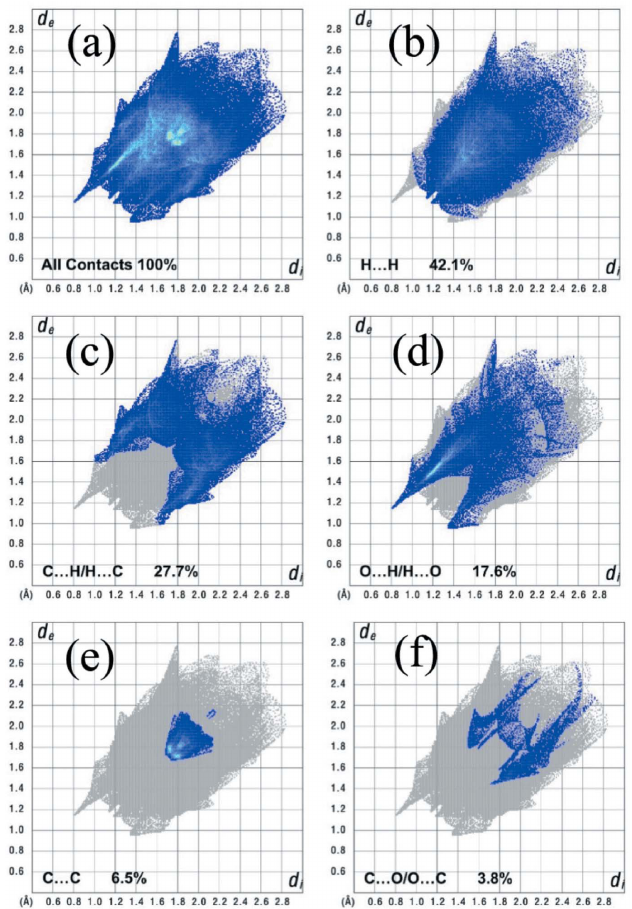
Figure 5 Two-dimensional fingerprint plots for the title compound, showing ( a ) all interactions, and delineated into ( b ) H (cid:2)(cid:2)(cid:2) H, ( c ) C (cid:2)(cid:2)(cid:2) H/H (cid:2)(cid:2)(cid:2) C, ( d ) O (cid:2)(cid:2)(cid:2) H/ H (cid:2)(cid:2)(cid:2) O, ( e ) C (cid:2)(cid:2)(cid:2) C and ( f ) C (cid:2)(cid:2)(cid:2) O/O (cid:2)(cid:2)(cid:2) C interactions. The d i and d e values are the closest internal and external distances (in A˚ ) from given points on the Hirshfeld